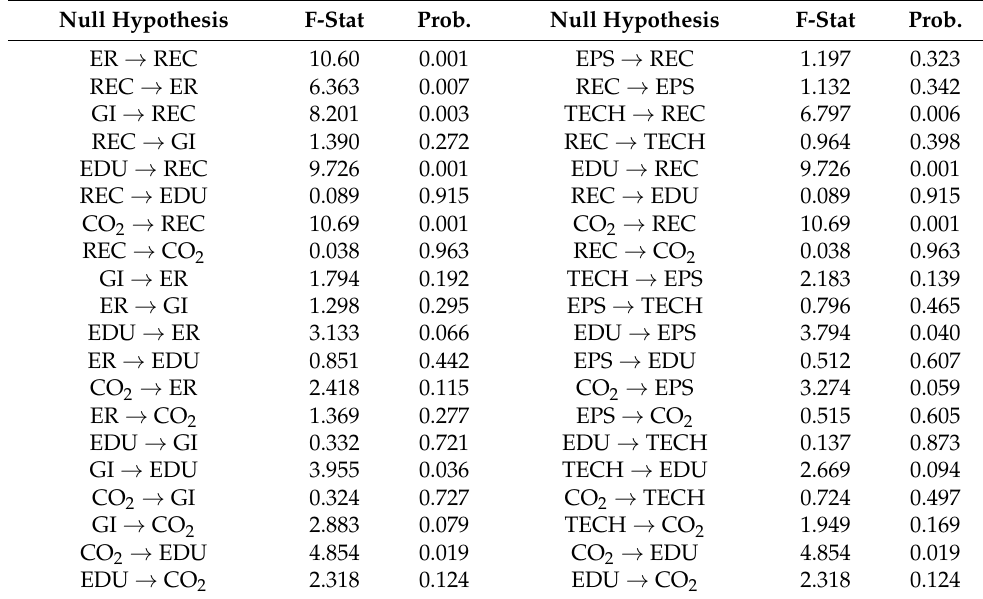
Table 4. Results of causality